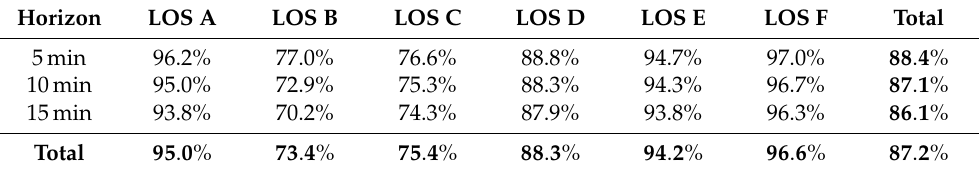
Table 1. Global performance